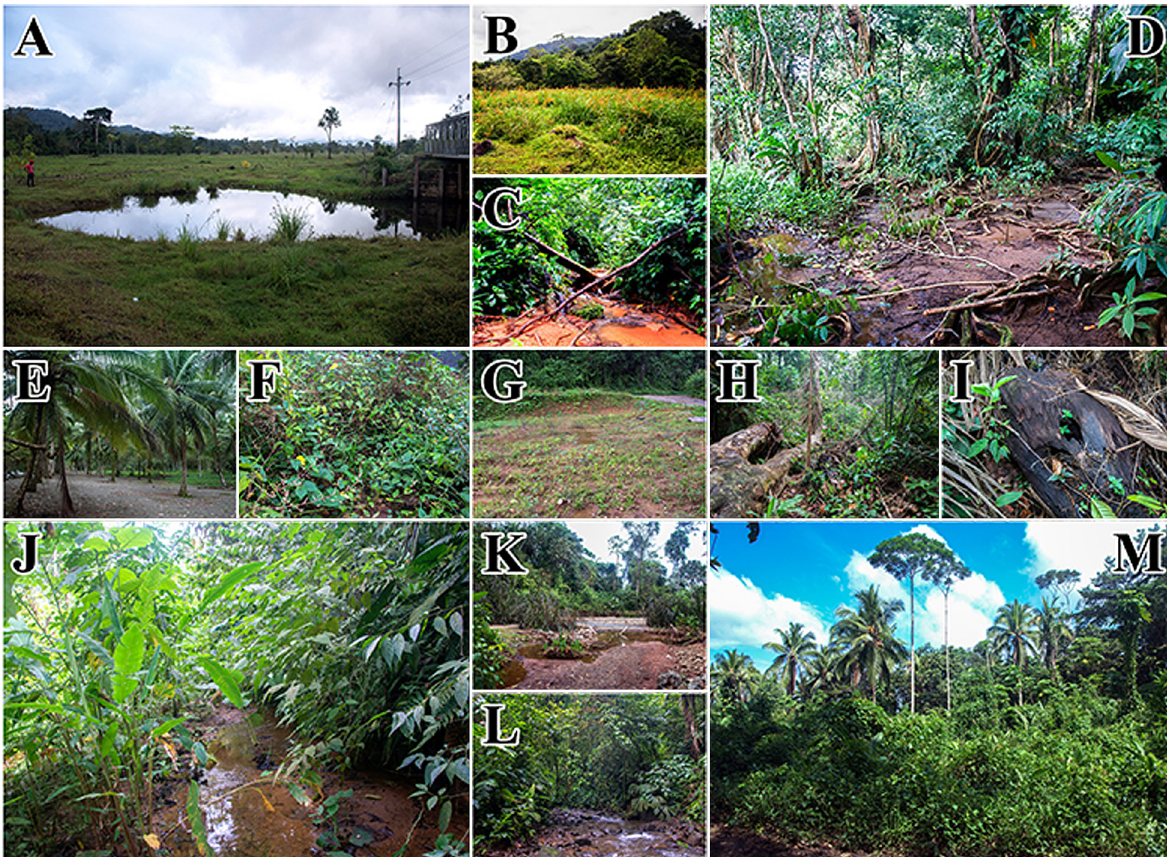
Figure 2. Bahia Solano habitats. A . Babillal via El Valle, B . Babillal near the airport, C . Coca-Cola Beach, D . Huina Beach, E . Mecana Beach, F . L. vacillans habitat near Principal Park, G . Puddles near Principal Park, H . Playa Larga, I . M. coerulatus habitat at Playa Larga, J, K . Quebrada Seca, L . Toledo Reserve, and M . El